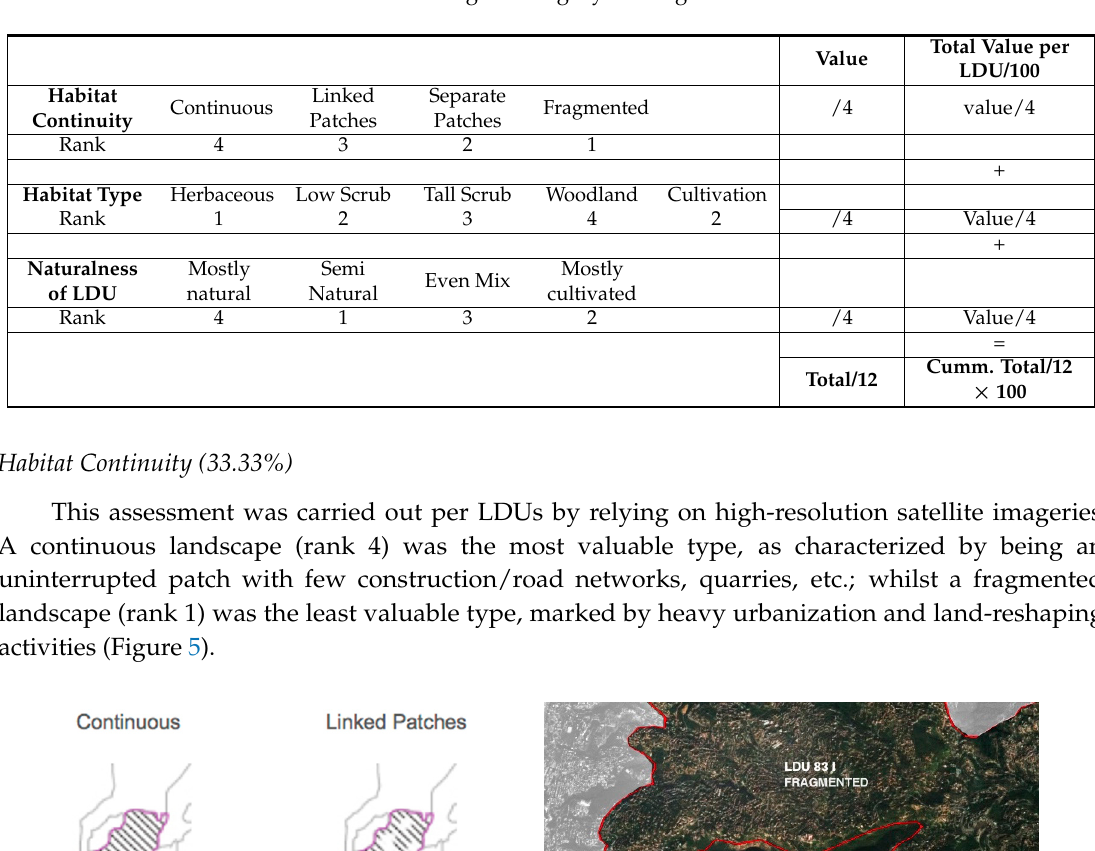
Table 4. Ecological Integrity ranking method.